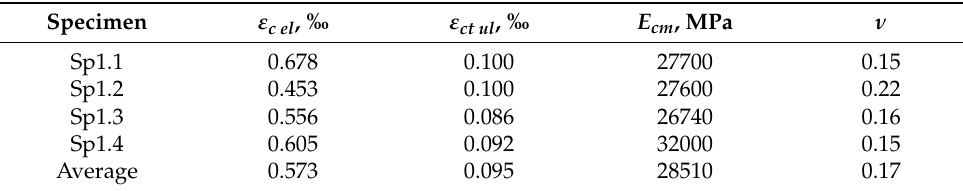
Table 3. Experimental values of maximum elastic and ultimate transverse concrete strains, modulus of elasticity, E cm , and Poisson’s ratio, ν